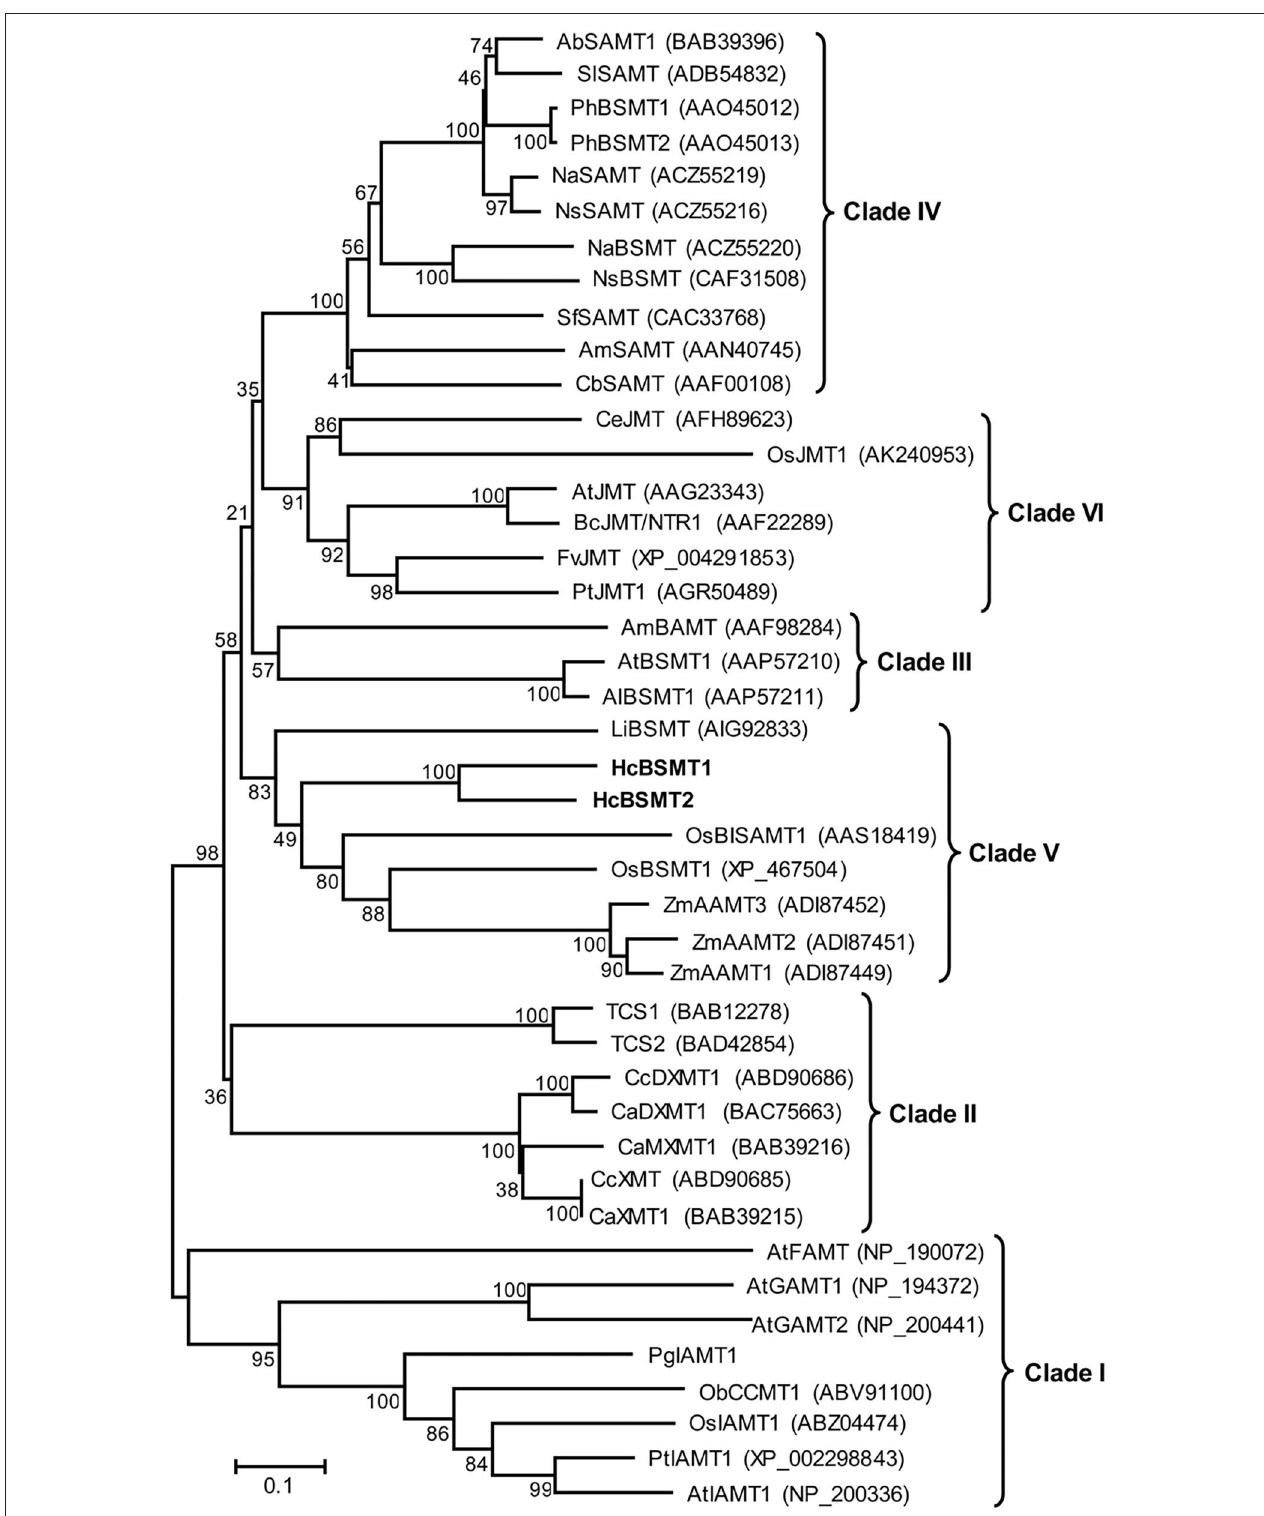
FIGURE 6 | Phylogenetic analysis of plant SABATH family. The phylogenetic tree was constructed based on protein sequences of functionally characterized members in the SABATH family using the neighbor-joining method. The members of plant SABATH family are classified into six clades (Clade I through Clade VI). Proteins identified from H. coronarium are in bold. The scale bar indicates 10% sequence divergence. The numbers at each branch indicate bootstrap percentages from 1,000